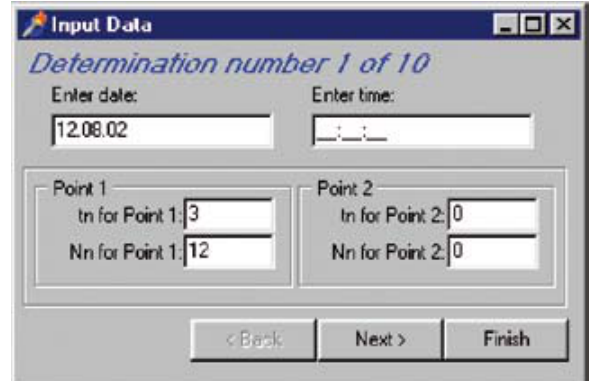
fig. 6 . Interactive window for the input of parameters to calculate the flow distribution